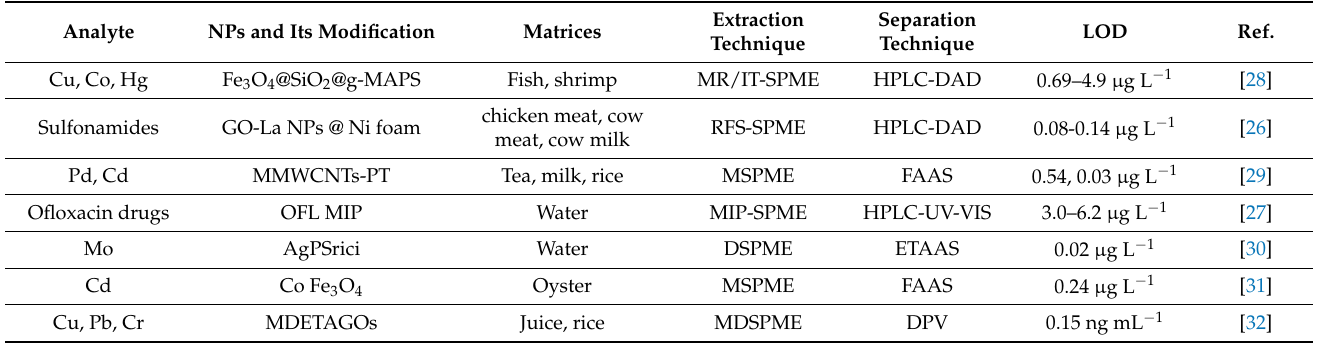
Table 4. Types of nanosorbents used in SPME.